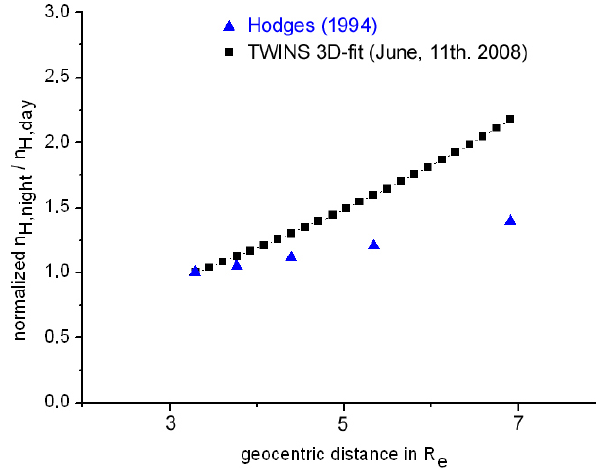
Fig. 7. Measured TWINS Ly- α -intensity profile in Rayleigh (11 June 2008) plotted versus the “line-of-sight” (LOS) earth passing geocentric distance in R E . The red area is showing the calcu- lated LOS-intensities based on the 3-D r,θ,φ -dependent “Bonn”- H-density model which fits the general profile and is able to explain the width of scattering within the profile.